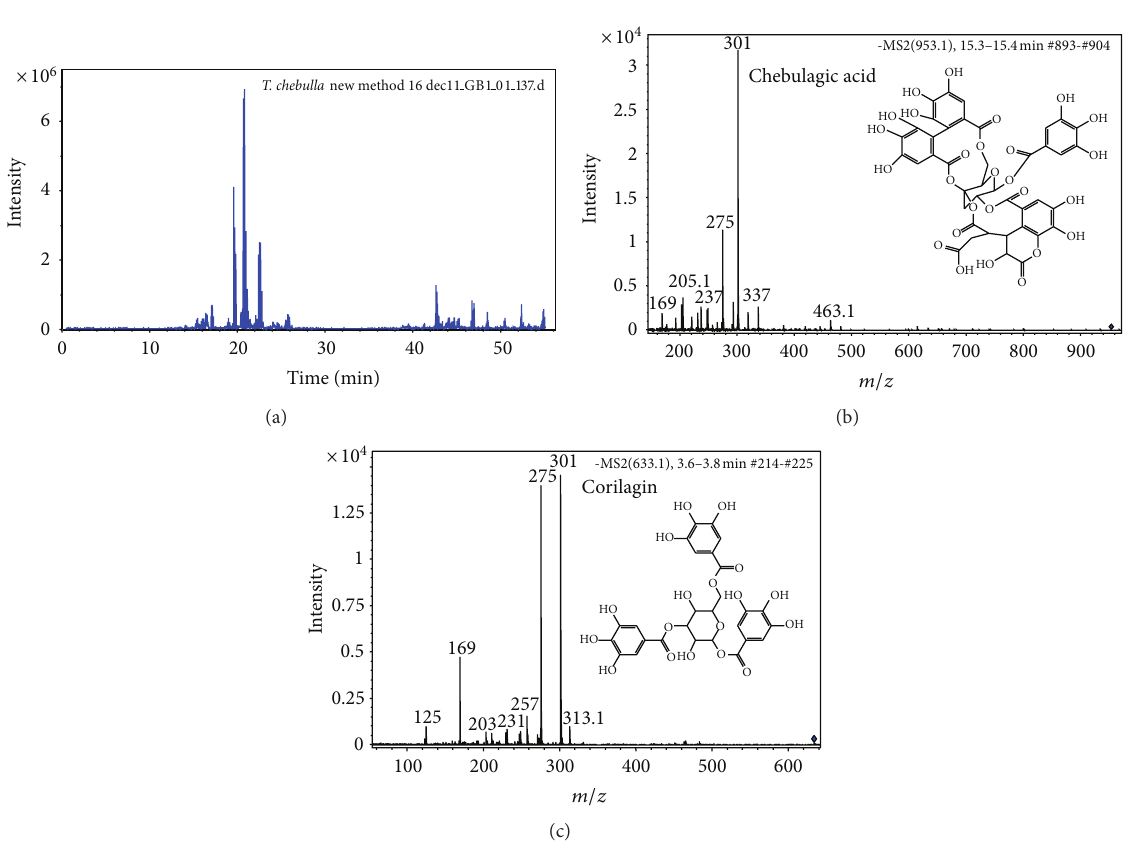
Figure 1: Chromatograms obtained from reversed-phase LC-ESI-QTOF-MS analysis of Terminalia chebula extract. (a) Total ion chromatogram (QTOF MS); (b) and inset in (b) corresponding to m/z for the most intense peaks of MS/MS spectrum pattern of Chebulagic acid; (c) corresponding to m/z for the most intense peaks view of MS/MS spectrum pattern of